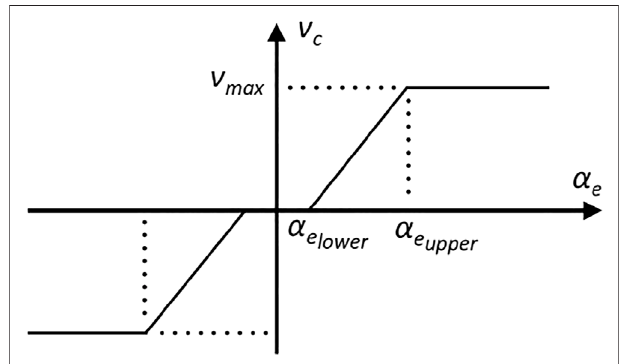
FIGURE9| Estimator fl owchart: F n and F t aremeasuredbyforcesensor, ^ F ^ μ c are estimated, and k and